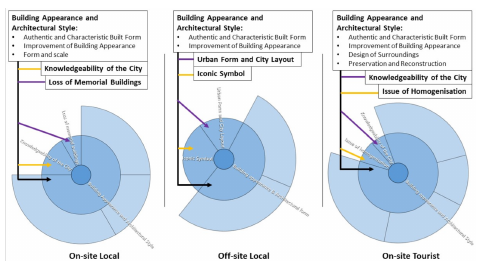
Figure 6. Results and categories—built heritage and iconic